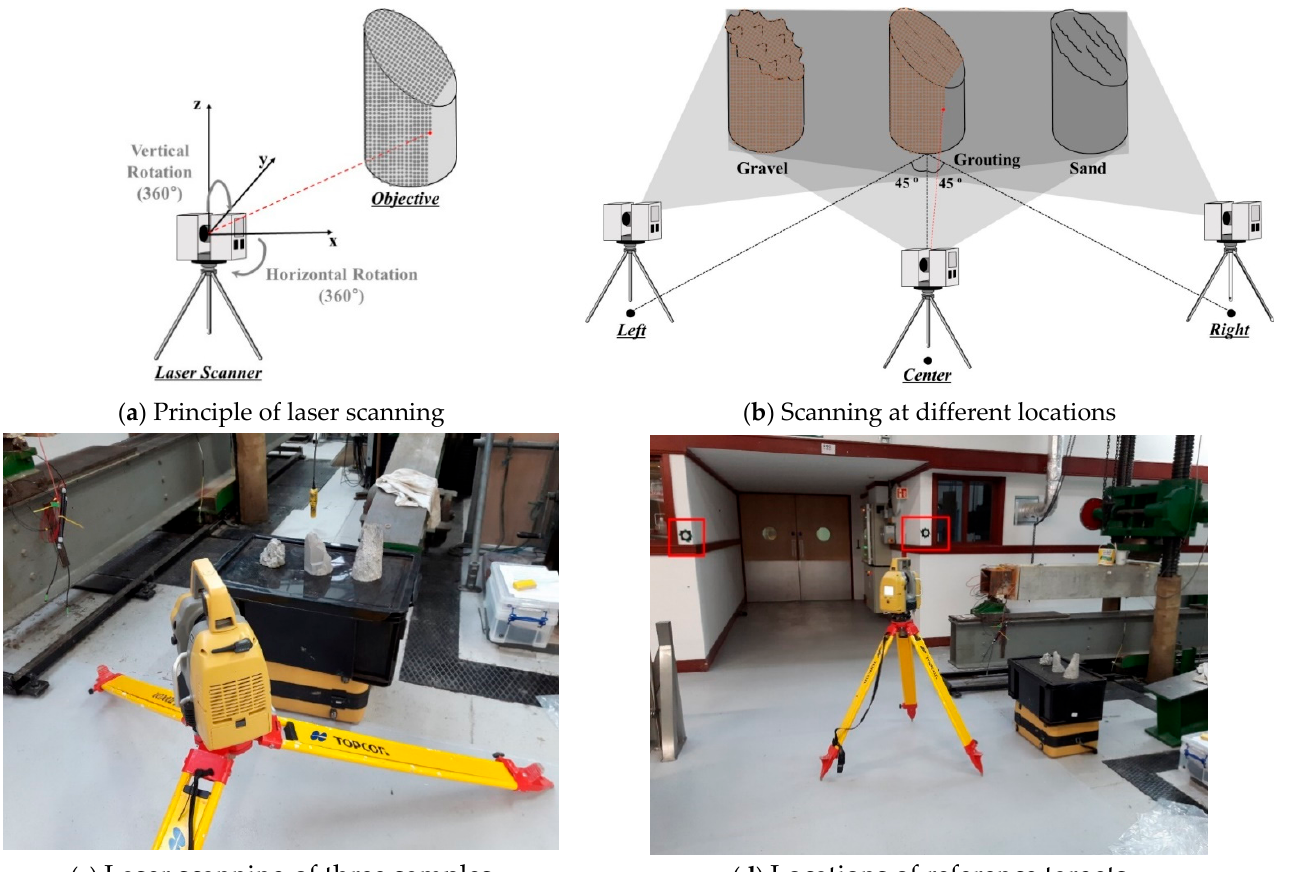
Figure 3. Scanning of three samples.